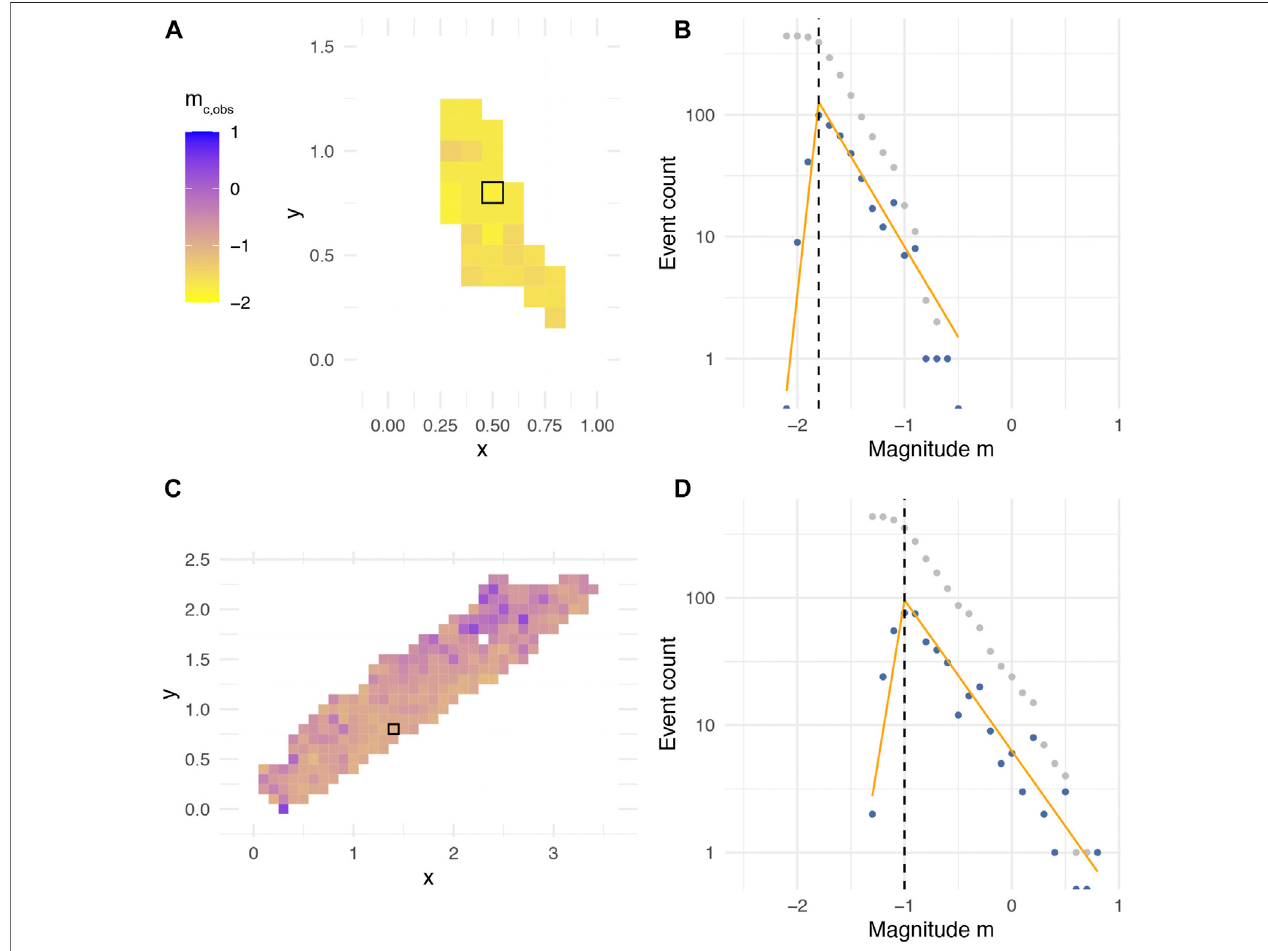
FIGURE2| Examples of100 m-resolution m c , obs maps and oflocalMFDs. (A) m c , obs map at depth z (cid:1) − 2 . 7 kmforthe1993Soultz-sous-For ˆ etsstimulation(S93) (B) local MFD observed in the cell highlighted on the S93 map, with Asymmetric Laplace distribution fi t (C) m c , obs map at depth z (cid:1) − 4 . 1 km for the 2012 Cooper Basin stimulation (CB12) (D) local MFD observed in the cell highlighted on the CB12 map, with Asymmetric Laplace distribution fi t.